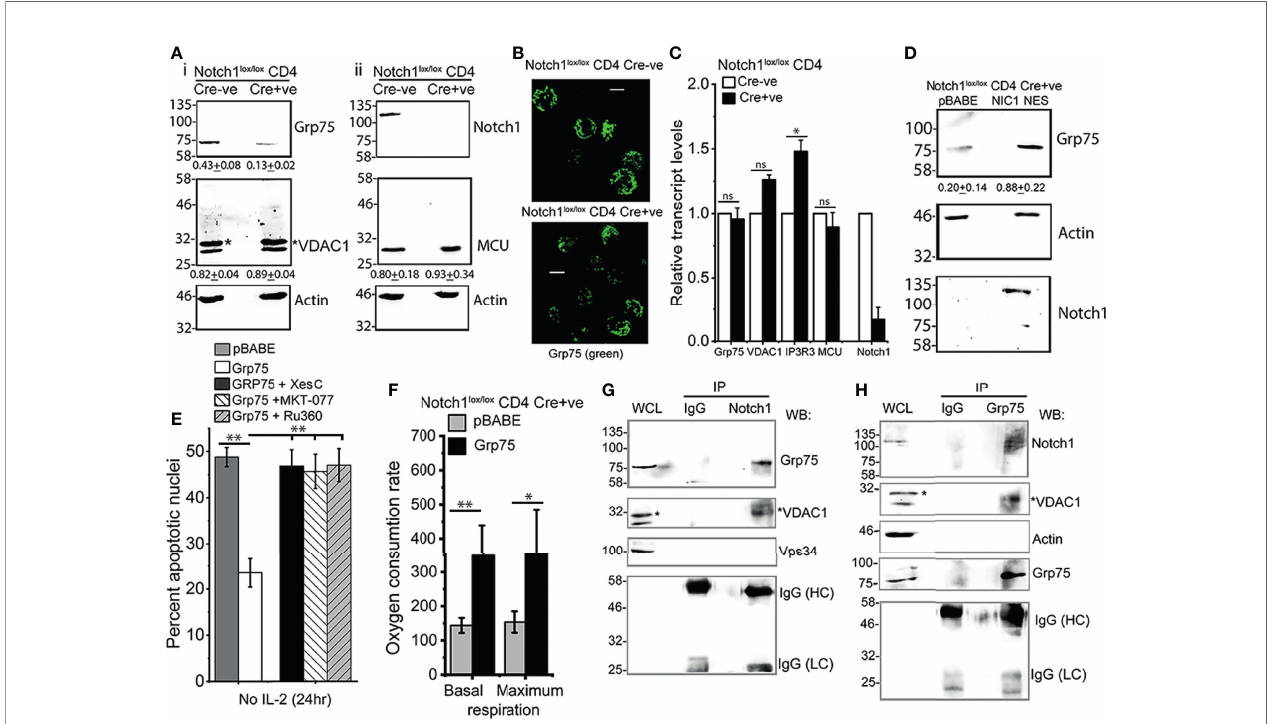
FIGURE 6 | Notch1 activity regulates Grp75 protein levels. (A) Immunoblots of whole cell lysates prepared from activated Notch1 +/+ (Cre-ve) and Notch1 -/- (Cre+ve; Cd4-Cre::Notch1 lox/lox ) Tregs, run in duplicate. Membranes were sequentially probed for Grp75, VADC1 (*VDAC1 band), and Actin (A-i) or Notch1, MCU and Actin (A-ii). Mean ± SD values below are the densitometry analysis of Grp75, VDAC1 and MCU relative to Actin. (B) Representative Z-projected confocal images of Notch1 +/+ and Notch1 -/- Tregs immune-stained with an antibody to Grp75 (green). scale bar: 5 m m. Images are representative of 106 Notch1 +/+ Tregs and 82 Notch1 -/- Tregs. (C) Relative transcript levels of indicated genes in Notch1 +/+ and Notch1 -/- activated Tregs. (D) Immunoblots of cell lysates from Notch1 -/- Tregs transduced with pBABE or NIC1-NES probed for Notch1, Grp75 and Actin. Mean ± SD values below are the densitometry analysis of Grp75 relative to Actin. (E) Percent apoptotic nuclei in Notch1 -/- Tregs transduced with pBABE or Grp75, cultured without IL-2 for 24 h with 5 m M Xestospongin C or, 10 m M MKT-077 or, 10 m M Ru360. (F) Basal and maximum OCR in Notch1 -/- Tregs transduced with pBABE or Grp75. Control (pBABE) condition in panels E and F are common Figures 5B, D as these were tested in the same experiment, as described in methods . (G, H) Cell lysates of WT activated Tregs cultured for 6 h without IL-2 were subject to immunoprecipitation using an antibody to Notch1 (G) or Grp75 (H) or, IgG (Isotype control), and associated proteins analyzed by western blotting